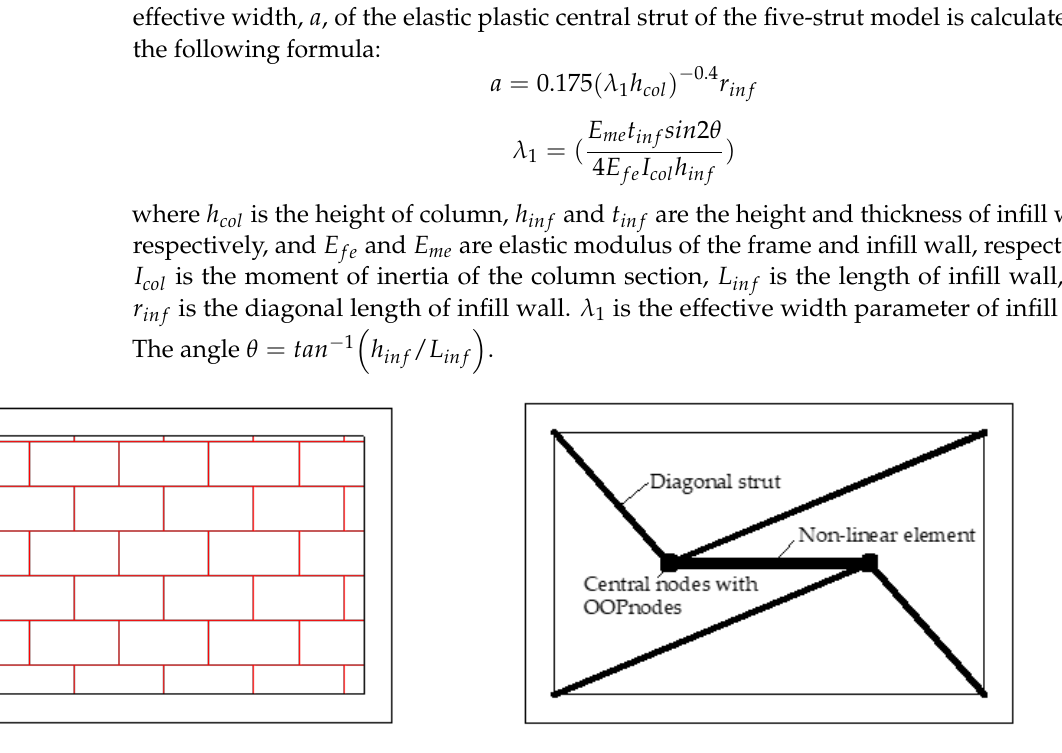
Figure 4. Five-strut model of masonry infill wall.